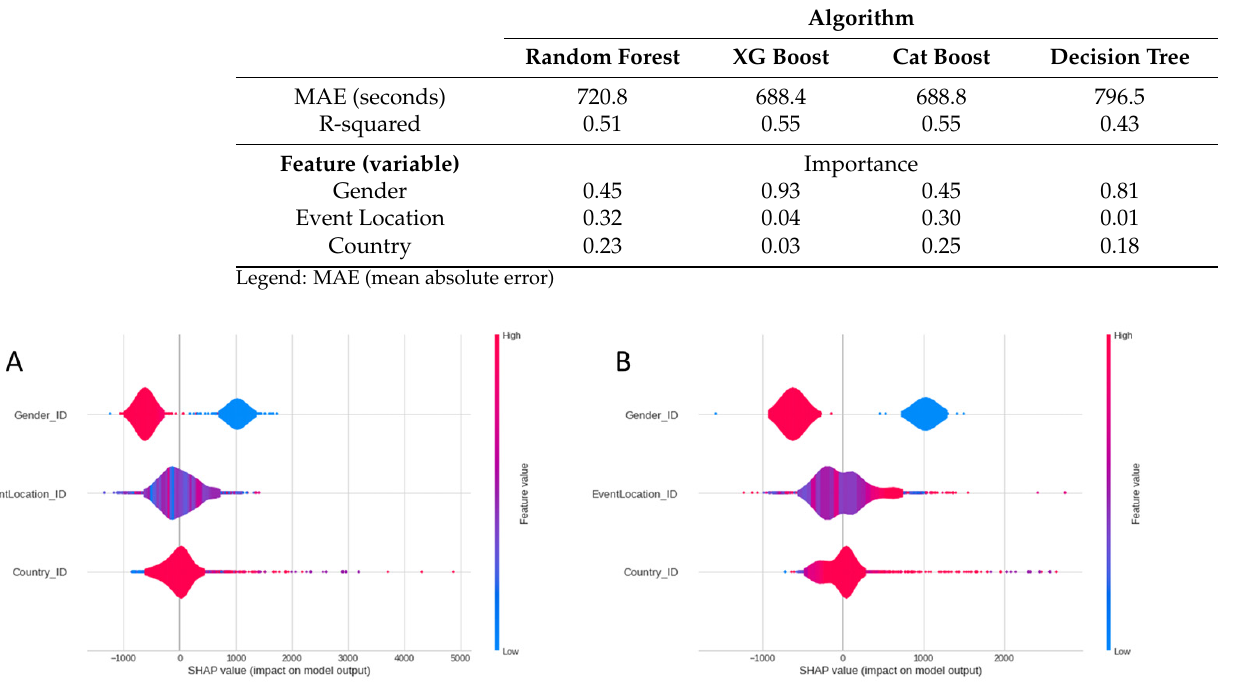
Table 1. Regression models results using the four different algorithms.